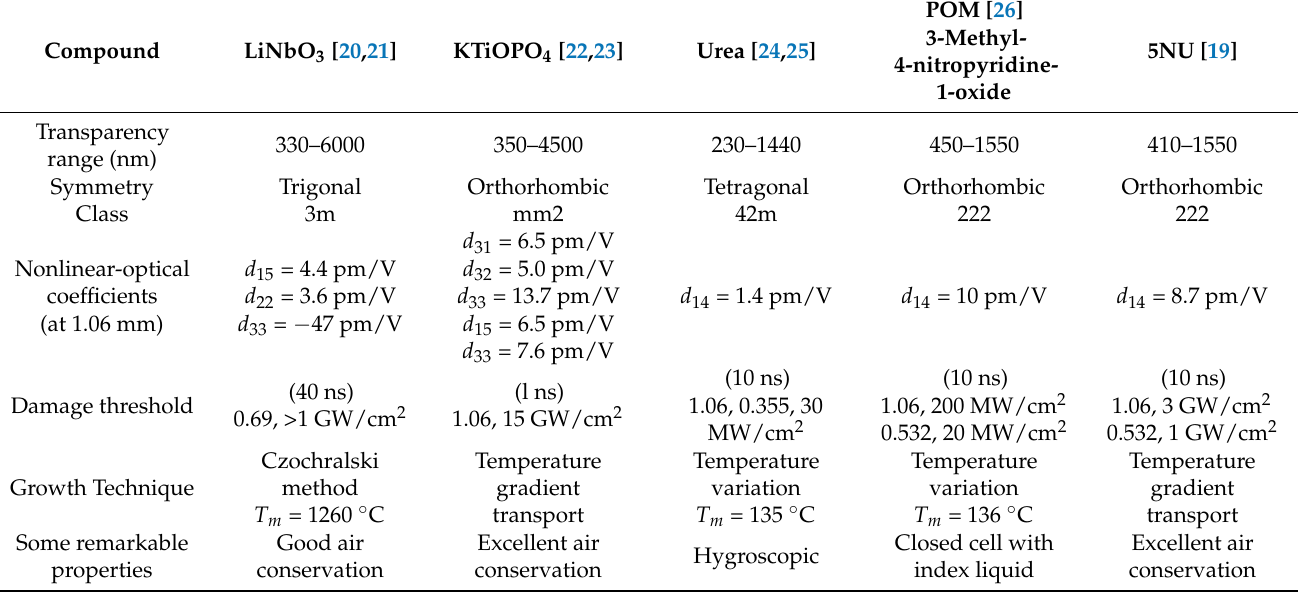
Table 1. Comparison of 5NU with some well-known mineral and organic crystals; adapted with permission from Ref. [19], 1993, Optica Publishing